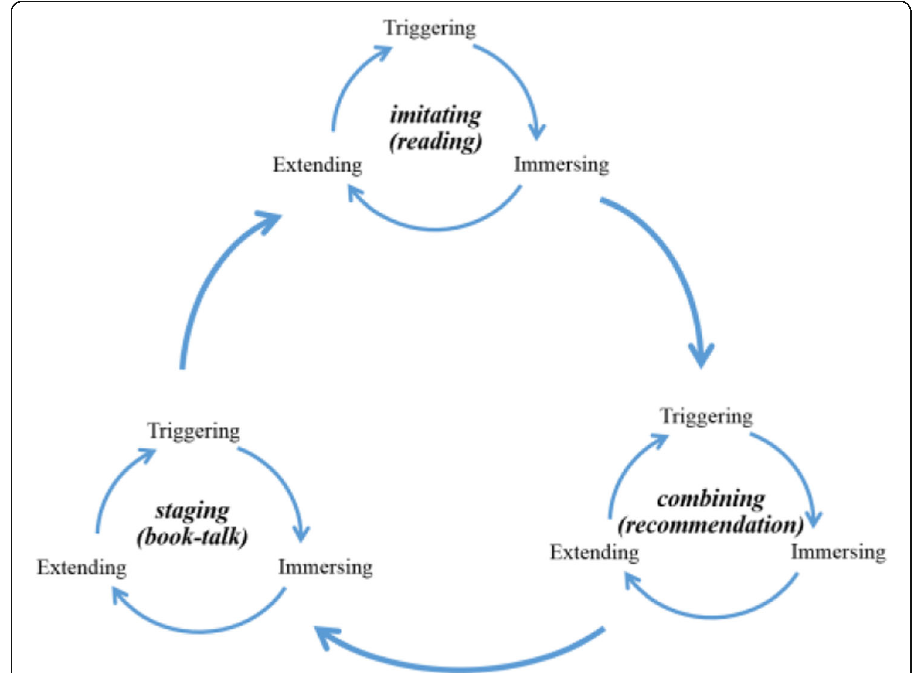
Fig. 2 The interest-driven creation loop design of